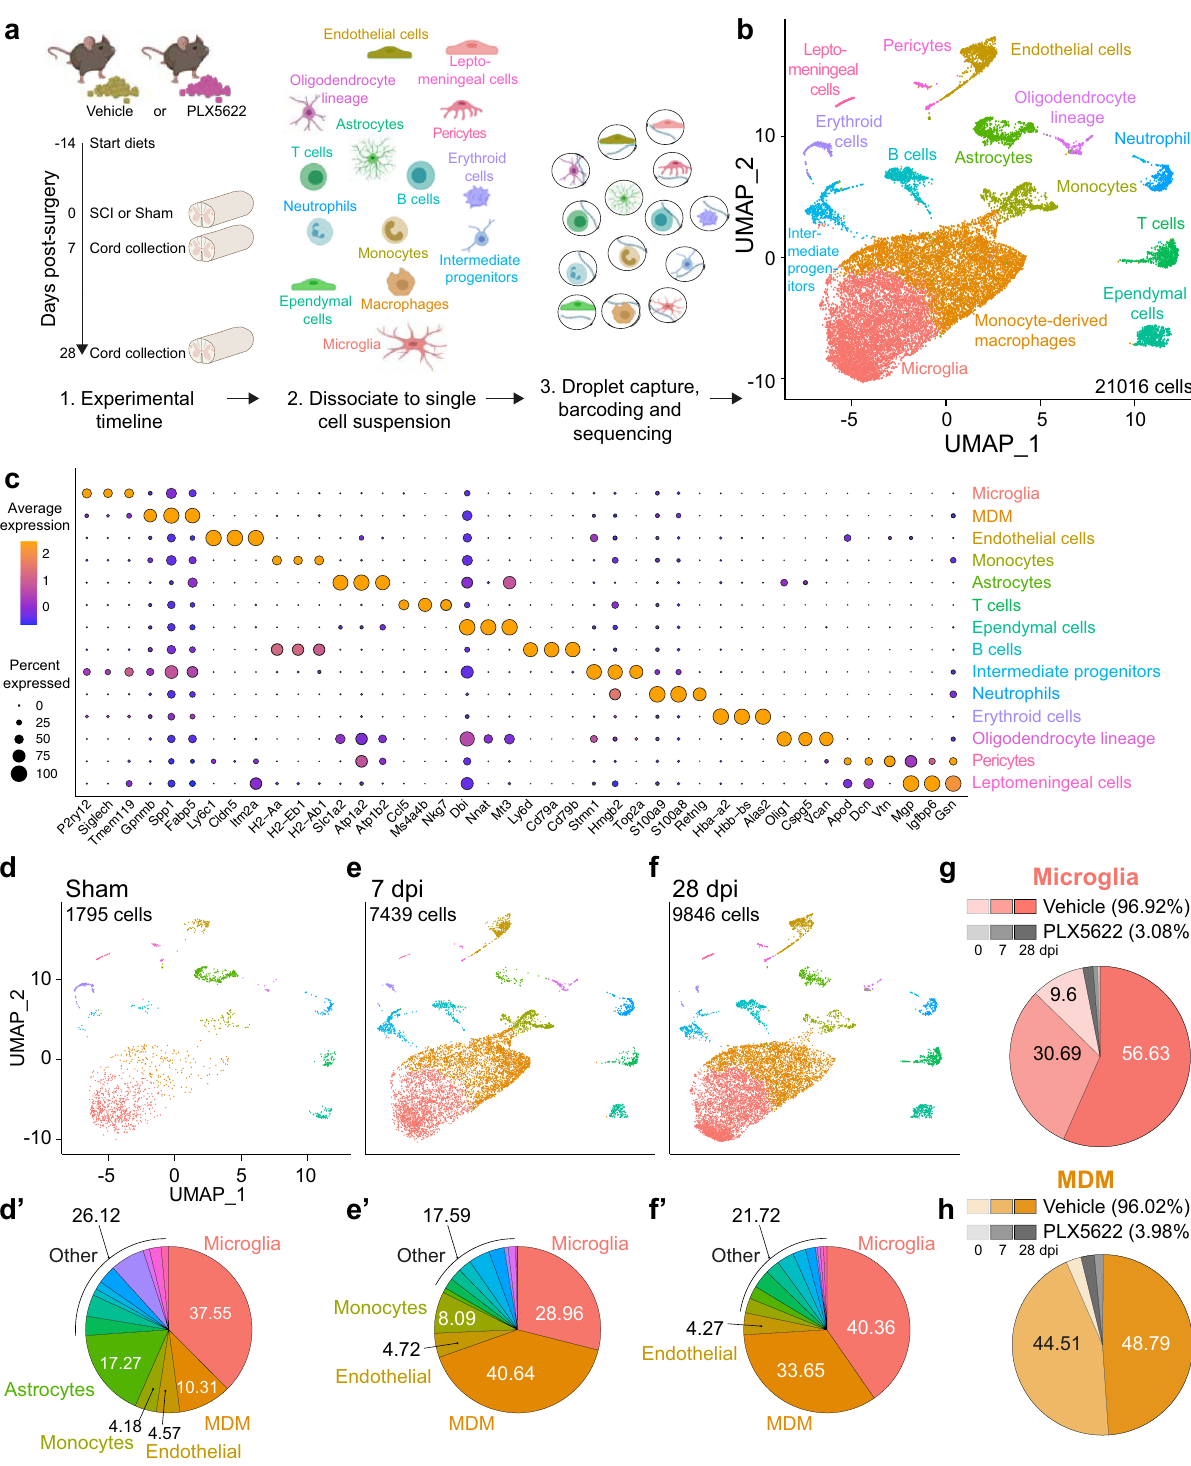
Fig. 4 Single-cell RNA sequencing of the mouse spinal cord reveals changes in cell composition after SCI and microglia depletion. a Mice received either vehicle or PLX5622, starting 2 weeks before surgery, until 7 or 28 days post-surgery. At the end point, single-cell RNA sequencing was performed on fresh (un- perfused) mouse spinal cords by dissecting a 1cm piece of fresh tissue (T4 – T13), including the meninges, centered on the laminectomy site. This method optimizes cell viability, allows comparison of leukocyte pro fi les present in both sham and SCI conditions, and enriches for resident glia and peripheral immune cells. b UMAP plot showing fourteen major cell types pooled from all groups. Each dot represents a single cell. c : Dot Plot showing the top 3 DEGs in each cluster based on adjusted p values. The dot color indicates the average scaled RNA expression of that gene in the cell type, and the dot size represents the percentage of cells in the cluster that express that gene. d – f UMAP plots of vehicle-fed mice split by time point. d ’ – f ’ The percentage of cell types in d – f . g , h Pie chart showing that most of the microglia ( g ) and MDMs ( h ) were derived from samples in the vehicle group. Data for each condition were pooled from n = 3 – 4 mice. Source data are provided as a Source Data fi le. See also Sup. Fig.